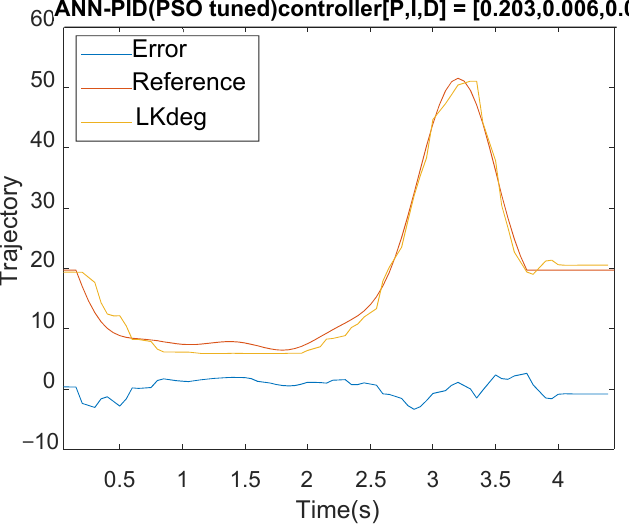
Figure 17. Feedforward ANN controller with PID system tracking results.